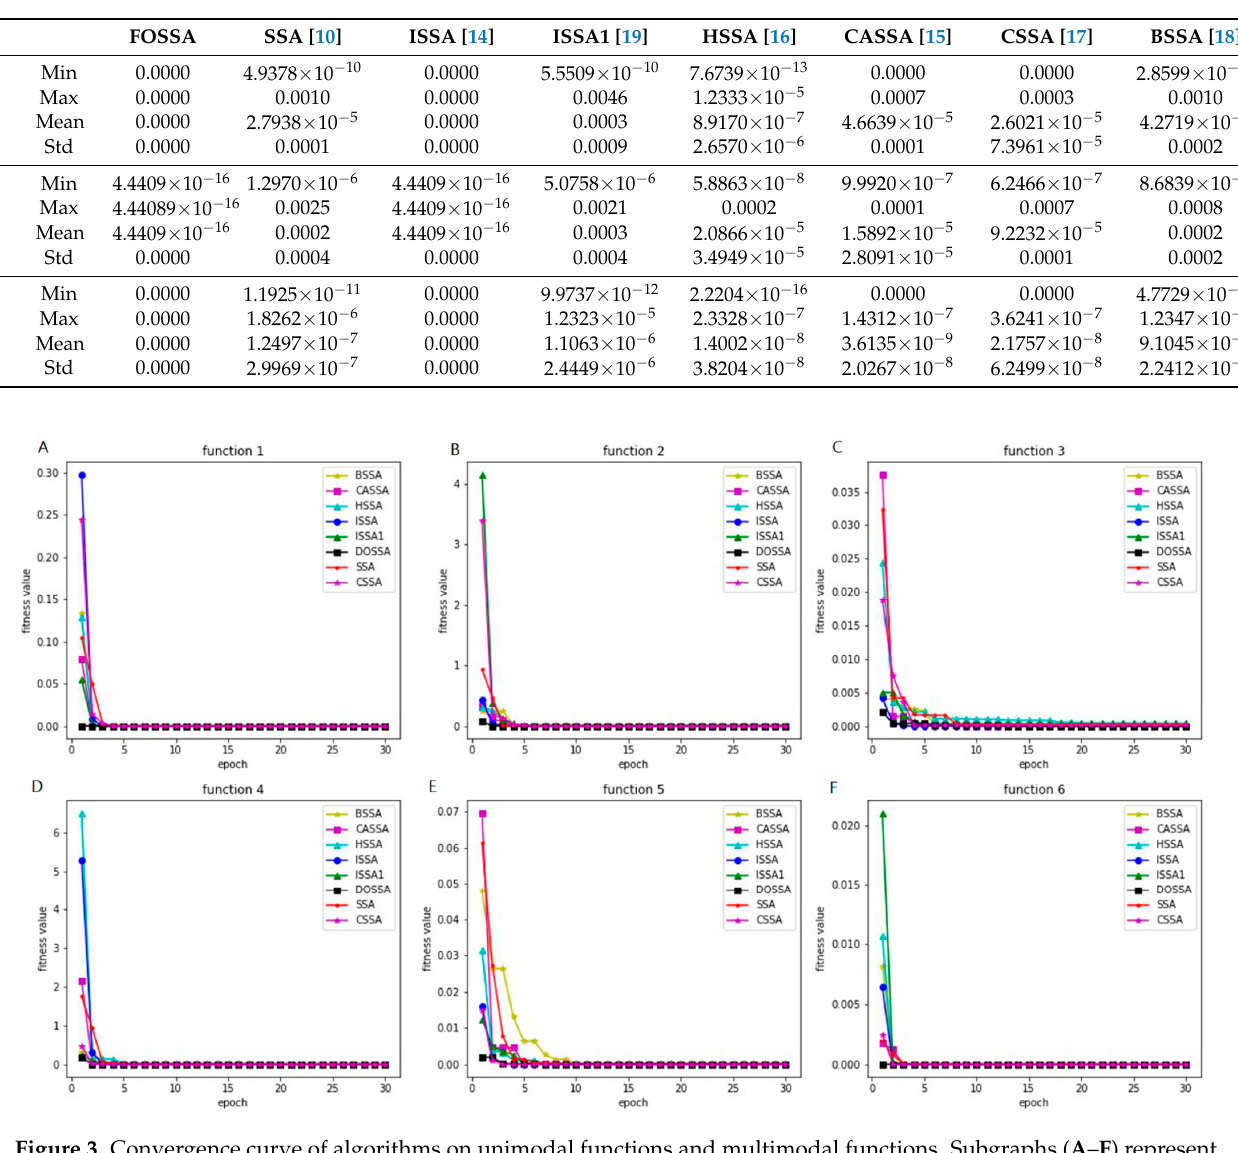
the convergence curve of benchmark function f 1 – f 6 . The quality of the initial population generated by the FOSSA algorithm